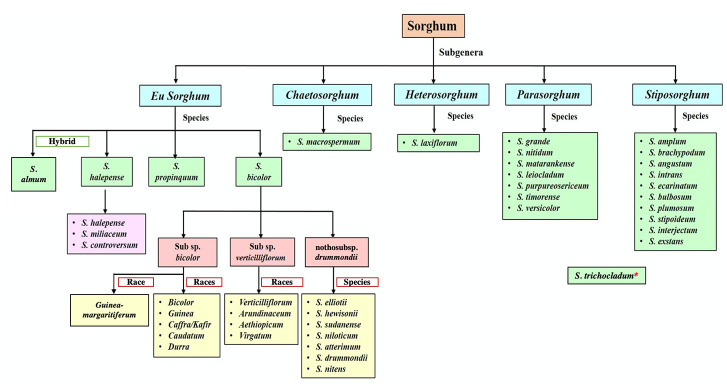
Classification of Sorghum (De Wet, 1978; Dillon et al., 2007a; Wiersema and Dahlberg, 2007; Venkateswaran et al., 2019a; USDA, 2020). *The exact position within the phylogeny is still uncertain.